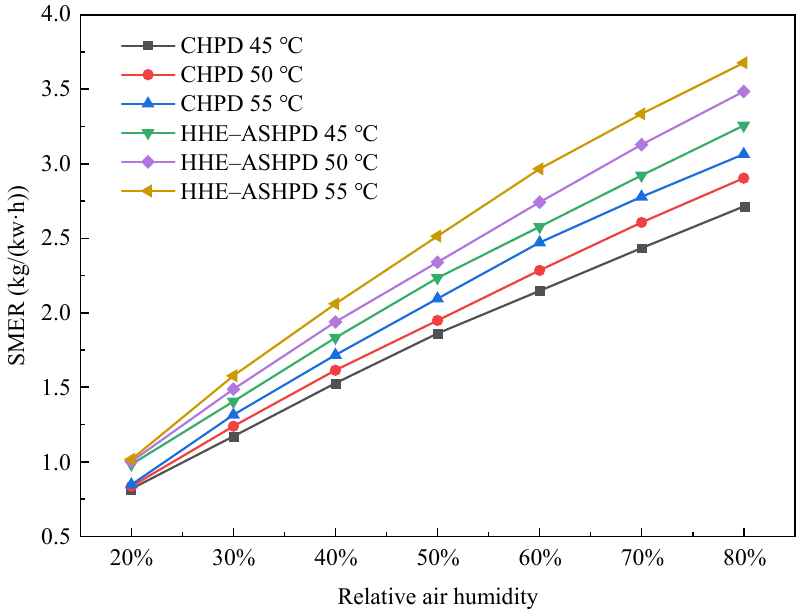
Figure 10. The influence on the SMER of two drying modes under different drying temperatures and humidity.